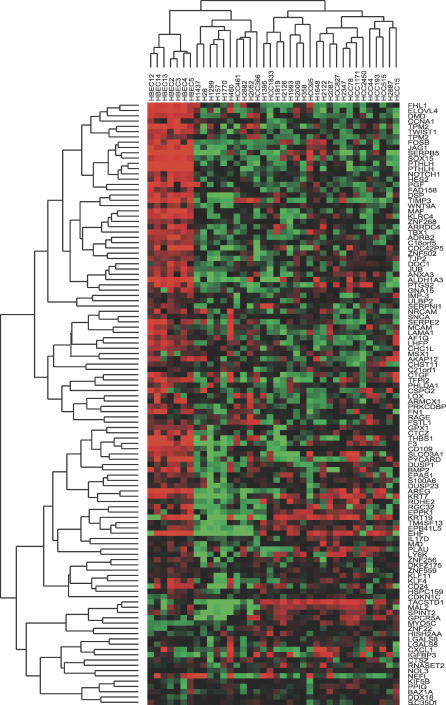
Complete-Linkage Cluster Analysis of 5-Aza-Induced Methylation Candidates in NSCLC and HBECsAnalysis was performed on a panel of 31 NSCLC cell lines (U133A and B) and seven HBEC lines (U133 Plus 2.0) with an overlapping gene set (117 genes). Data are mean-centered log2 expression values across the samples. Red indicates above the mean; green, below the mean. The 5-aza induction gene set separates cancer from HBEC lines and in most cases these genes are expressed at high levels in HBECs but not in NSCLC.